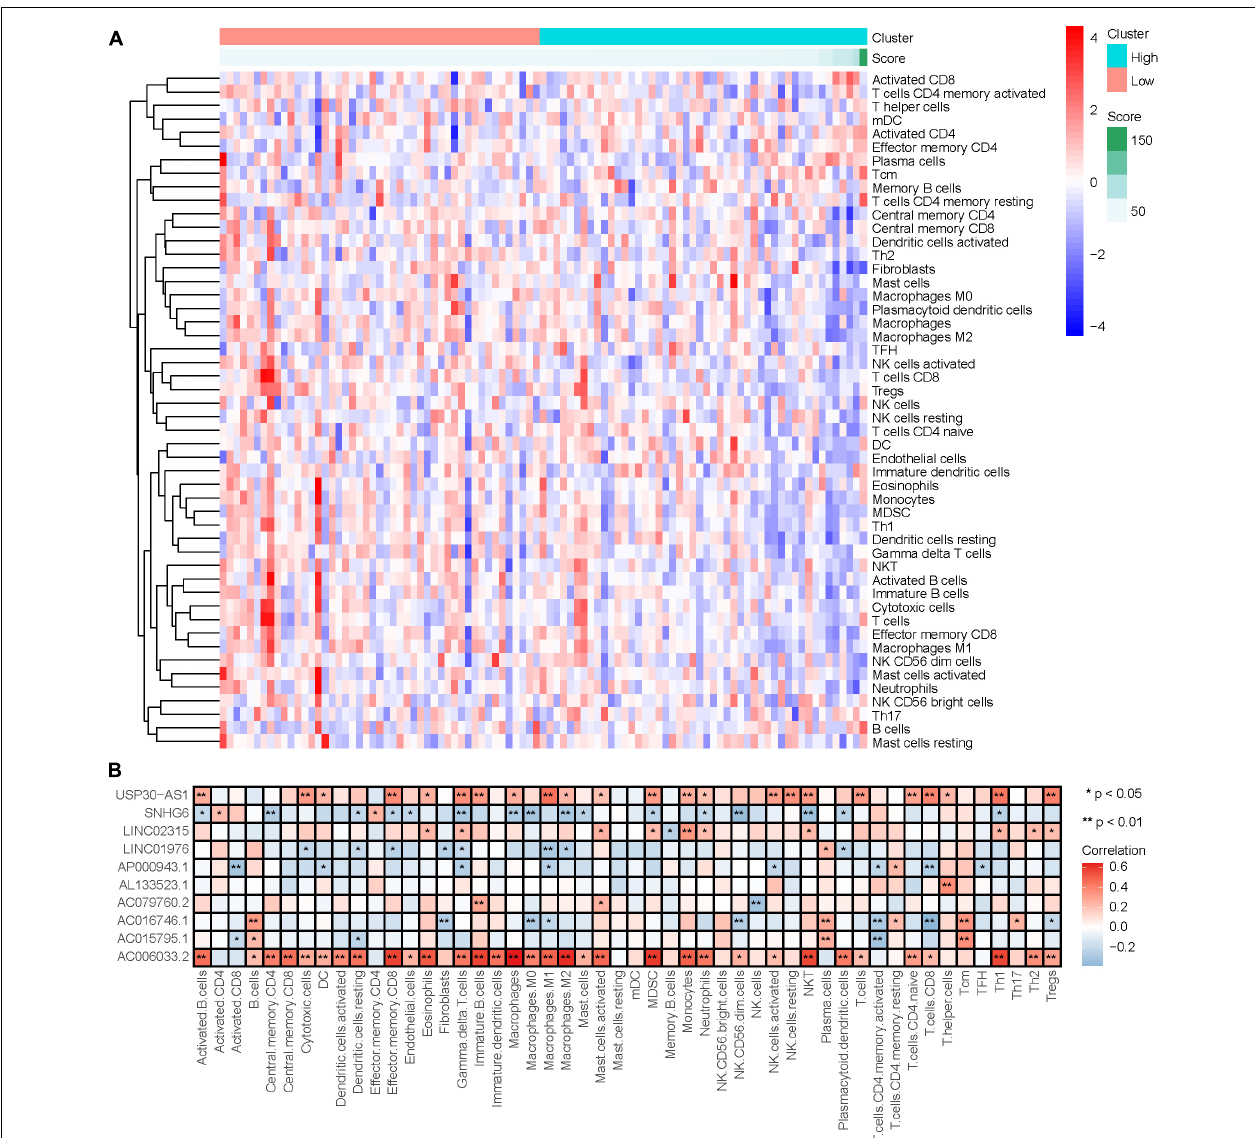
FIGURE 8 | Relationship between IRLs signature and the degree of immune cell infiltration. (A) Changes of the degree of immune cell infiltration in osteosarcoma with the change of risk score. (B) Correlation analysis between 10 IRLs and the degree of immune cell